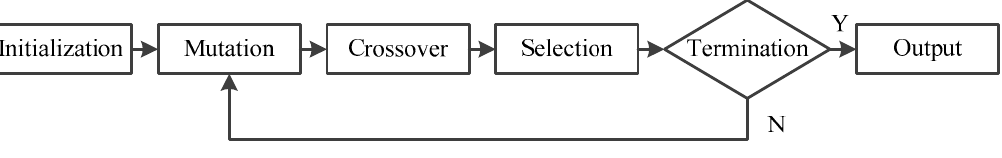
Figure 3. The flowchart of DE algorithm.